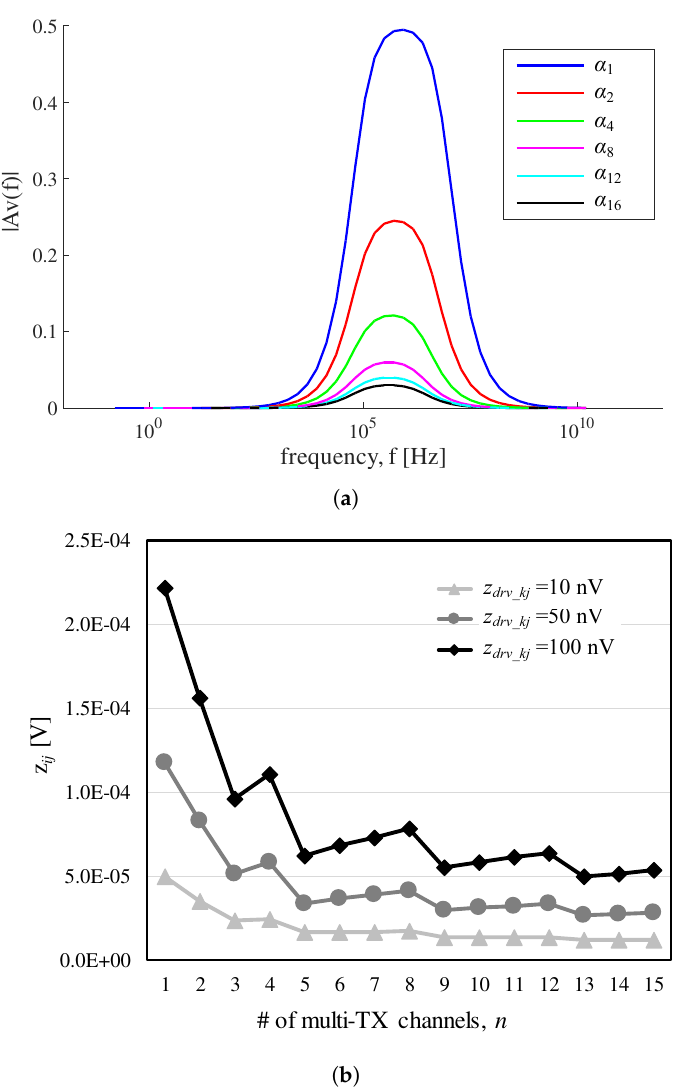
Figure 7. ( a ) A v ( f ) for different gain sets of CA, ( b ) Variation of z ij with respect to n without considering z ext